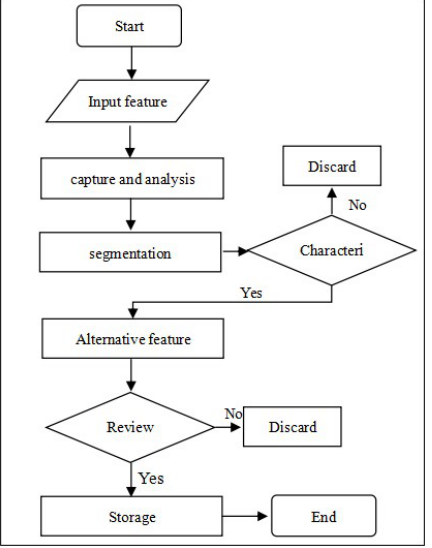
Figure 2 Feature extraction process